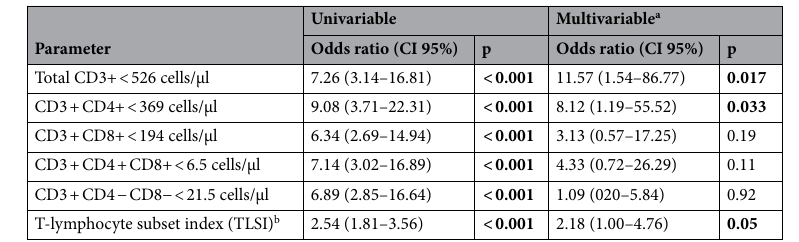
Table 6. Univariable and multivariable logistic regression analysis for in-hospital mortality-related risks in patients with SARS-CoV-2 infection. Statistically significant p values are highlited in bold. Univariable and multivariable logistic regression analyses were performed. Odds ratios and 95% Confidence Interval (CI 95%) are reported. A two-sided p value of < 0.05 was considered statistically significant. N/L ratio neutrophil- to-lymphocyte ratio, CRP C-reactive protein, LDH lactate dehydrogenase, AST aspartate transaminase, INR international normalized ratio, IL-6 interleukin-6. a Adjusting for age, gender, number of comorbidities, hemoglobin, white blood cell absolute counts, N/L ratio, CRP, LDH, AST, Creatinine, INR, d-dimer and IL-6. b The number of T-lymphocyte subset absolute counts under the cut-off value, ranging from 0 to